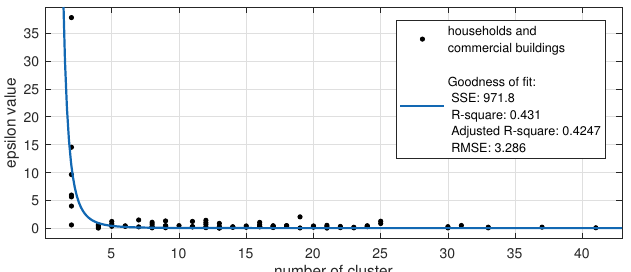
Figure 5. The relation between epsilon values versus number of clusters in dataset. Percentage of different categories in dataset